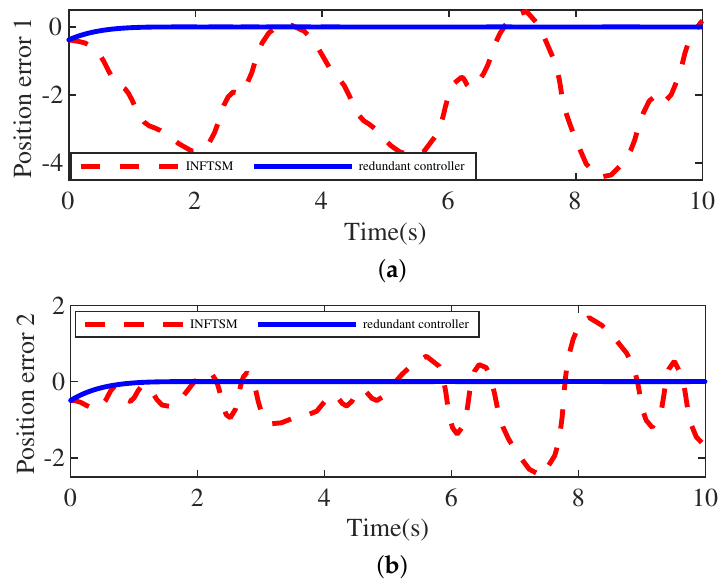
Figure 8. Comparison of position error when the system is in TLOE: ( a ) at joint 1 and ( b ) at joint